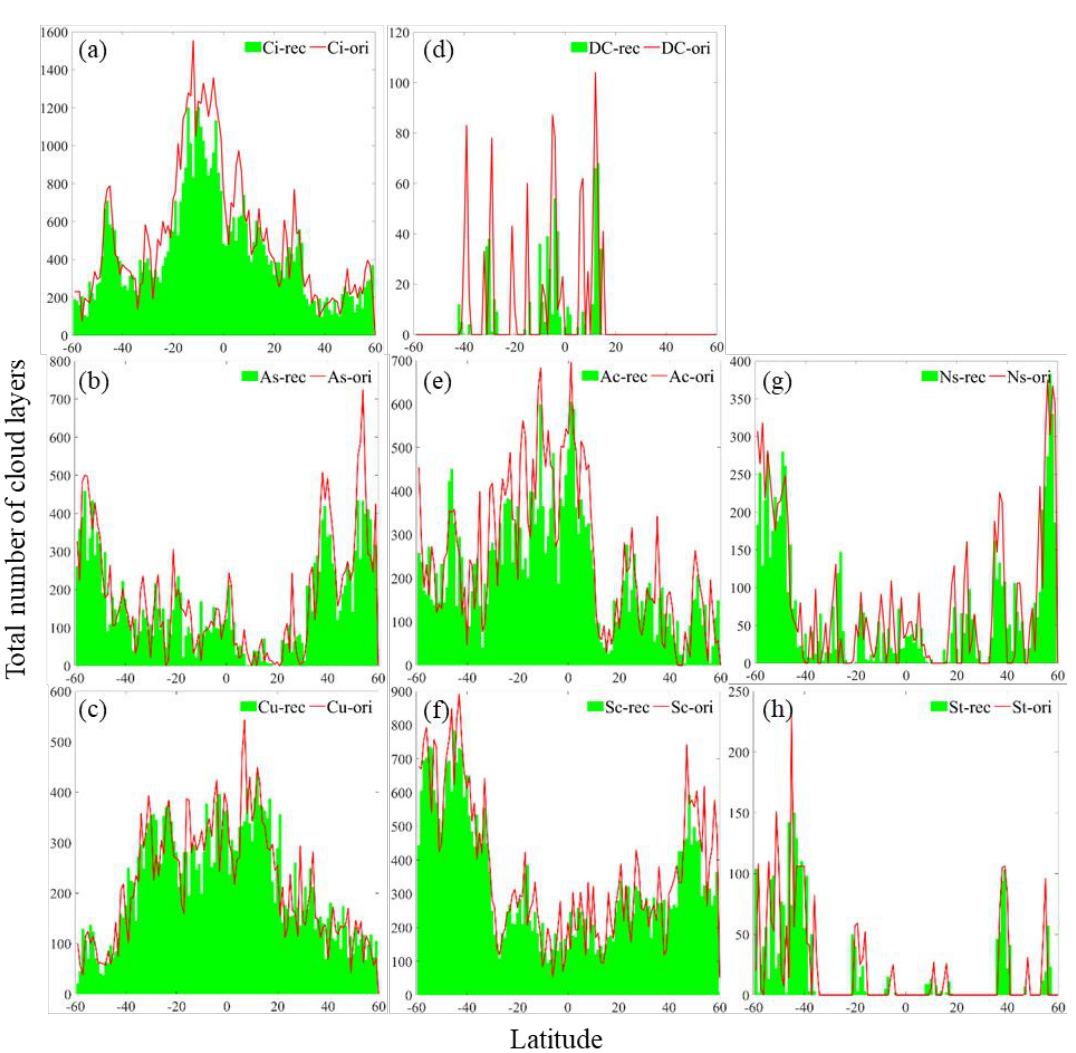
Figure 10. Summary of comparison between the clouds identified from the original profiles (ori) and the reconstruction profiles (rec) with a dead zone of 100 km. Each panel presents one of the eight cloud types, arranged from high, thin clouds to low, thick